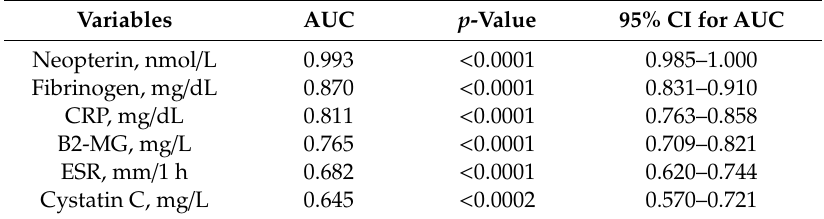
Figure 2. Receiver operating characteristic (ROC) curves for inflammation biomarkers and cystatin C. Table 4. Diagnostic test performance for biomarkers in PAD.